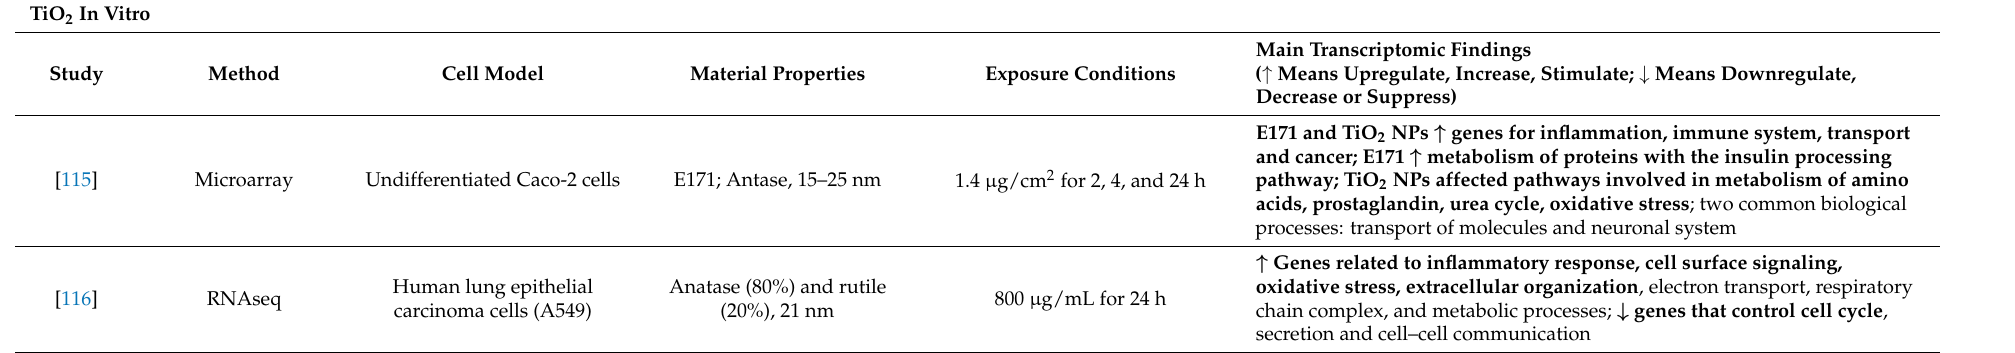
Table 2. Transcriptomic characterization of exposures to TiO 2 NPs in in vitro and in vivo